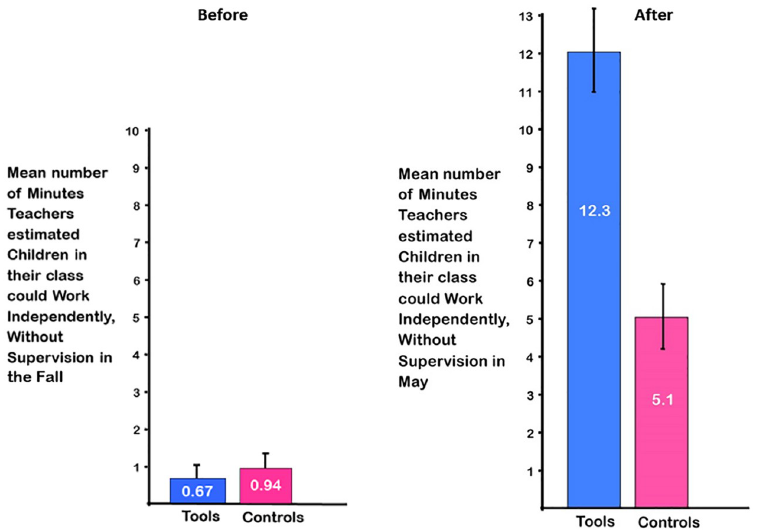
Fig 6. Ability of children to work on their own, unsupervised. By May, teachers in Tools felt their children could be left to work without supervision for far longer than did control teachers, although teachers’ estimates of this had been comparable in the